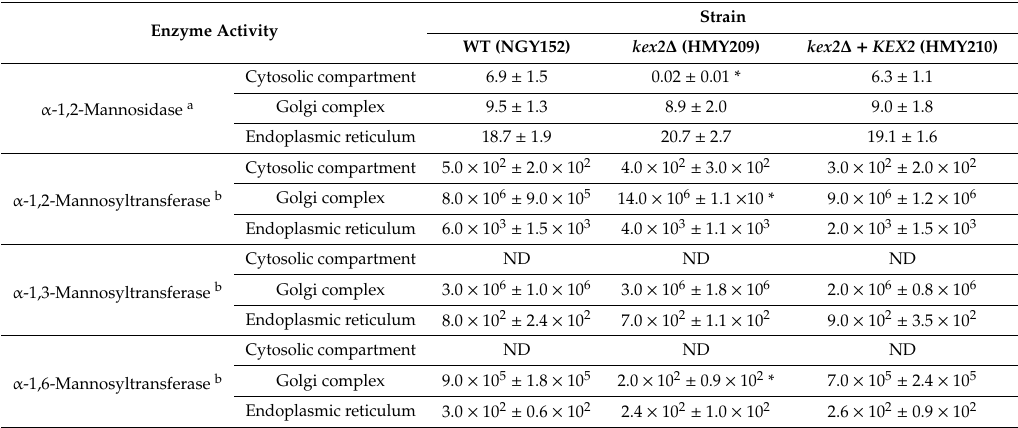
Table 3. Mannosidase and mannosyltransferase activities in some subcellular compartments of Candida albicans kex2 ∆ null mutant and control